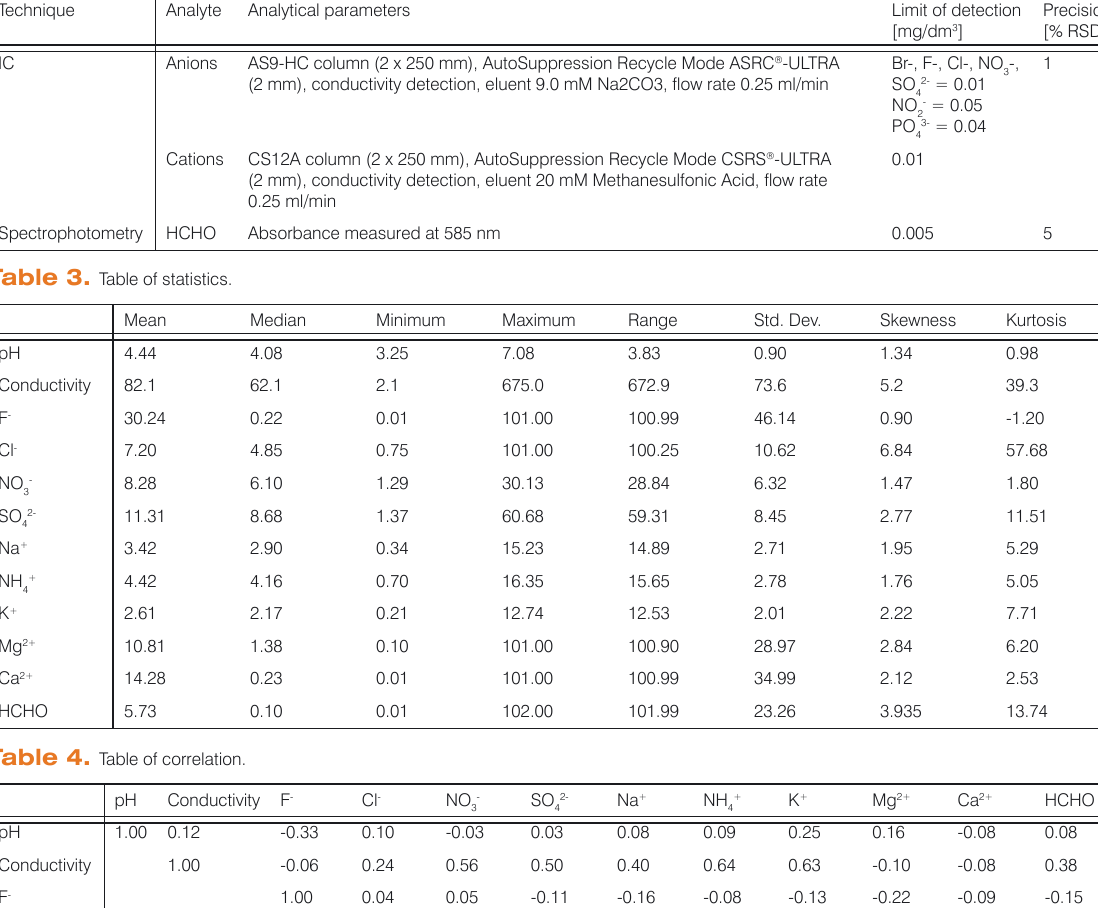
Table 2. Summary characteristics of the analytical techniques used in the study.